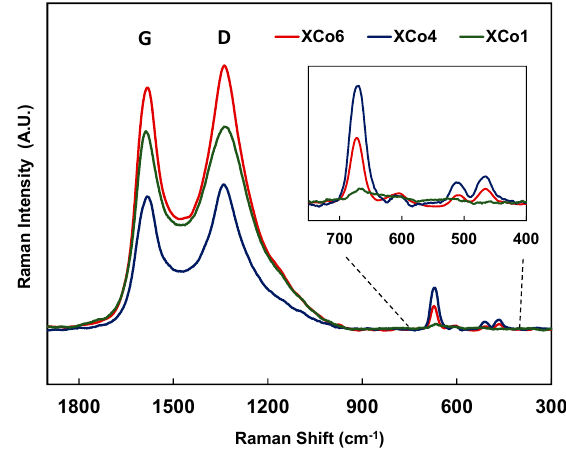
Figure 4. Raman spectra of the doped carbon xerogels.